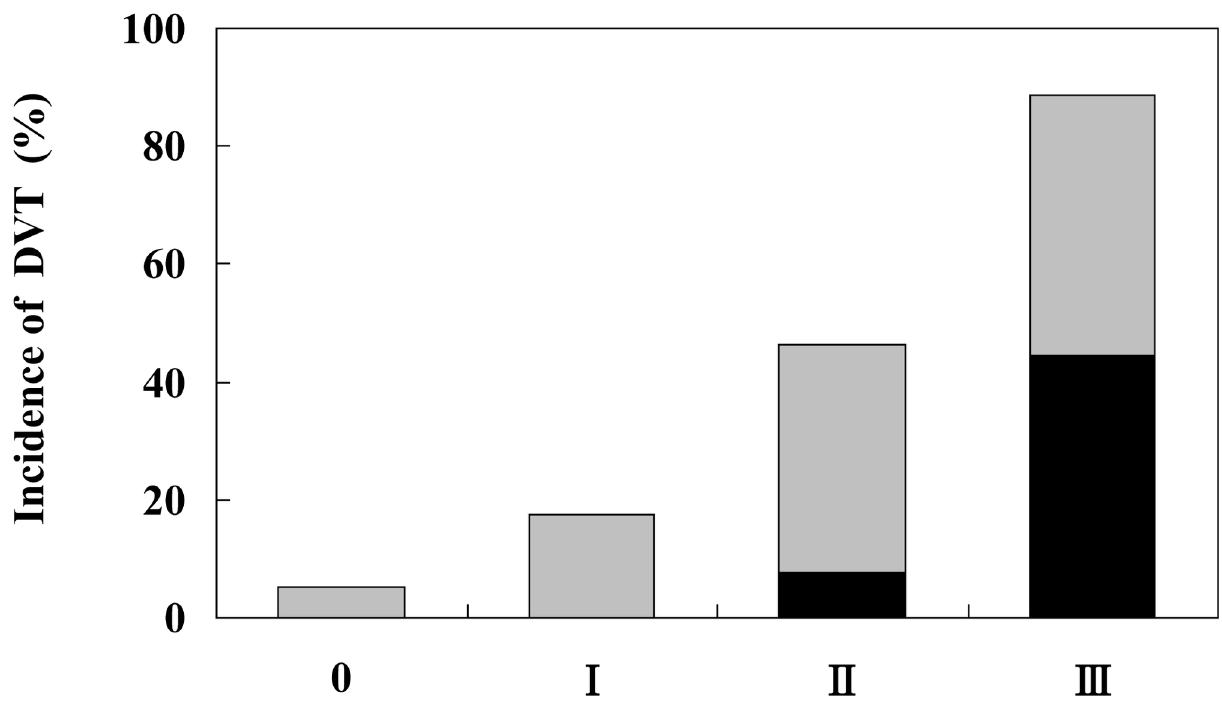
Figure 2. The correlation between the incidence of DVT and additional risk markers, including DM, D-dimer over normal limits, camptocormia, wheelchair use over 4 hours per day, and bent knee (>15°). 0 = no risk marker group (n=58) I = one risk marker group (n=34), II = two risk marker group (n=13), III = three or more risk marker group (n=9) (0 vs. I p=0.045 odds ratio 3.93, I vs. II p=0.045 odds ratio 4.0 II vs. III p=0.041, odds ratio 9.3). With respect to the additional effect of these 5 risk markers, a higher incidence of DVT is observed in patients having more risk markers. The vertical bar represents the % incidence of DVT in each risk marker group. The black box shows the % incidence of proximal DVT, and the grey one shows the % incidence of distal DVT.